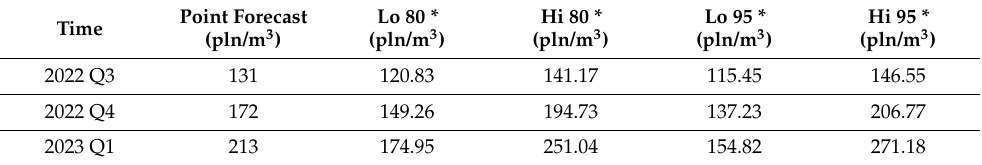
Table 1. Price forecast for M2 ZE assortment for Q3 of 2022, Q4 of 2022, and Q1 of 2023. Source: Own elaboration based on data obtained from the State Forests IT System (SILP-own elaboration based on the Computer Management Support System of the State Forests National Forest Holding).